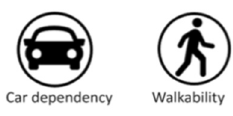
Figure 11. Encourage Walkability and Reduce Car Dependency.